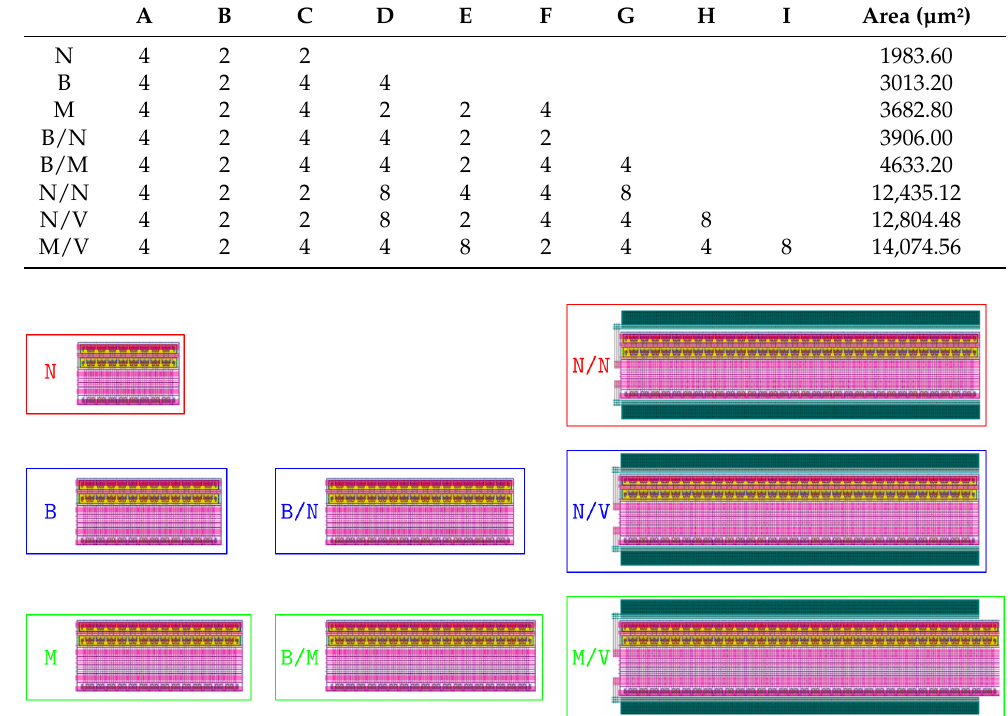
Figure 15. Amplifier